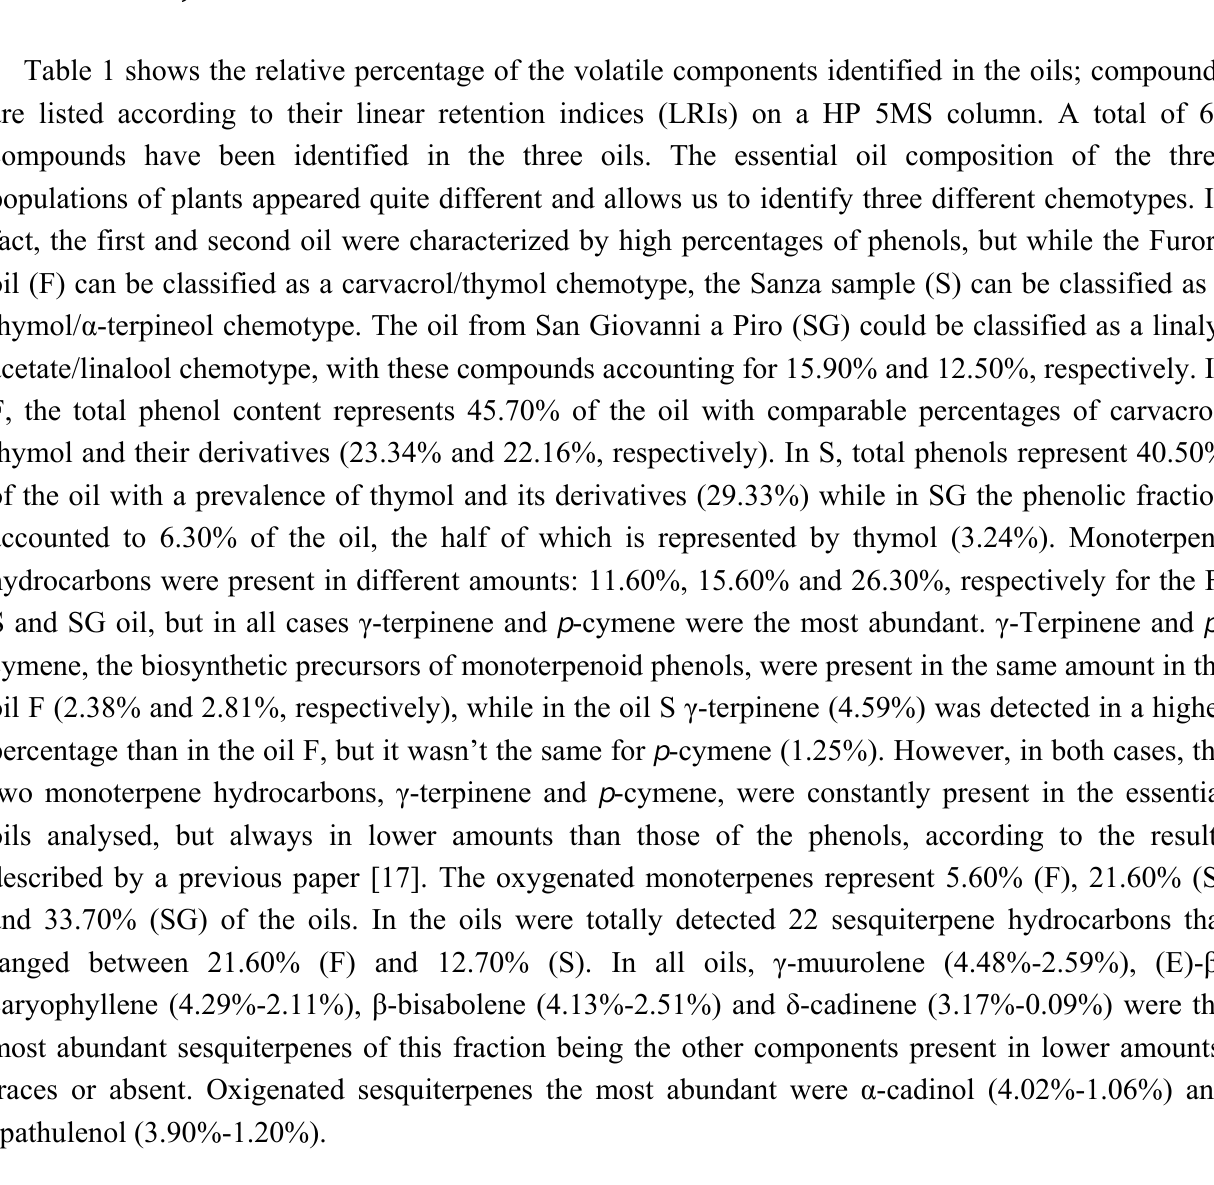
Table 1 . Essential oil composition (% of total) of aerial parts of O. vulgare ssp. hirtum (Lamiaceae) growing wild in Southern